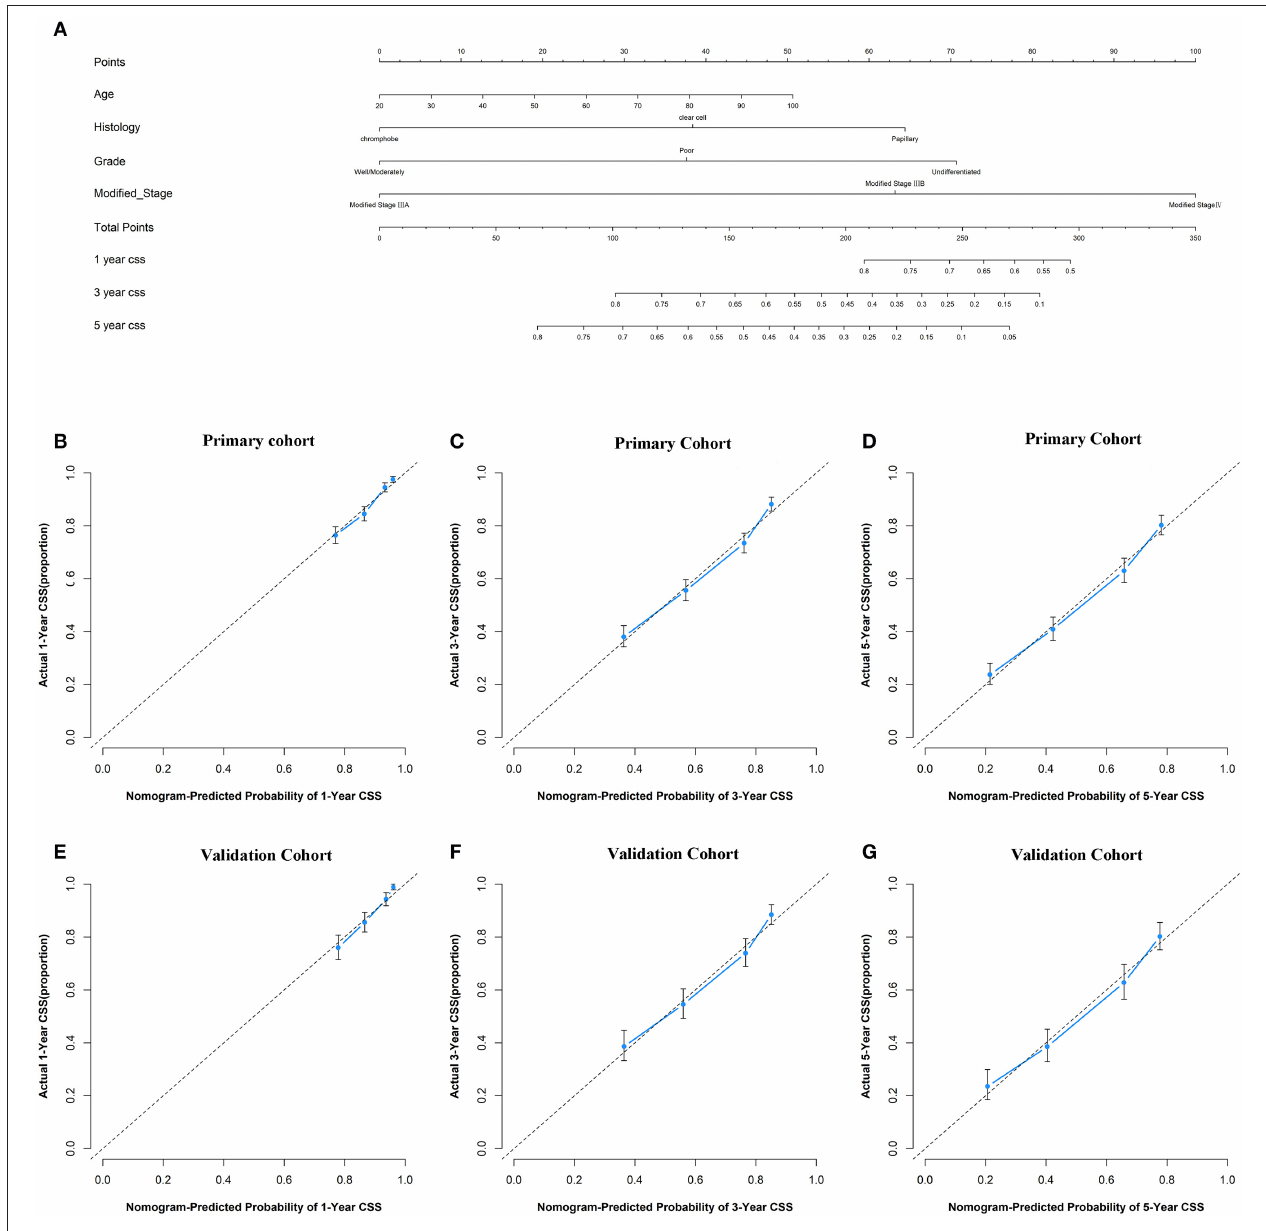
FIGURE 4 | Prognostic nomogram, calibration curves of cancer-specific survival (CSS) for the modified stage of study patients. (A) The nomogram predicts 1-, 3-, and 5-years CSS in patients with renal cell carcinoma (RCC). The calibration curves predict CSS at 1-year (B) , 3-years (C) , and 5-years (D) in the primary cohort and at 1-year (E) , 3-years (F) , and 5-years (G) in the validation